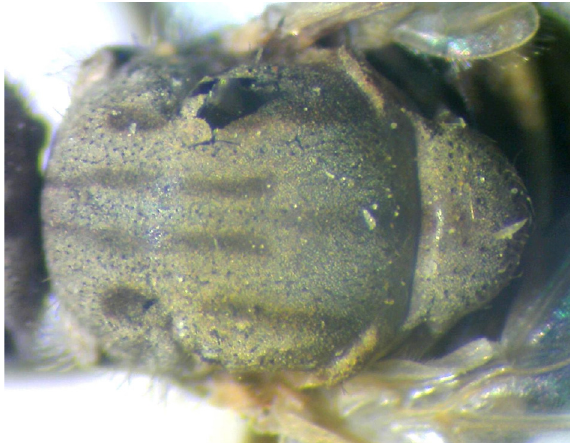
Fig. 30. Protypusia . sp. cf inornata (Engel, 1932) gen. et comb. nov.,